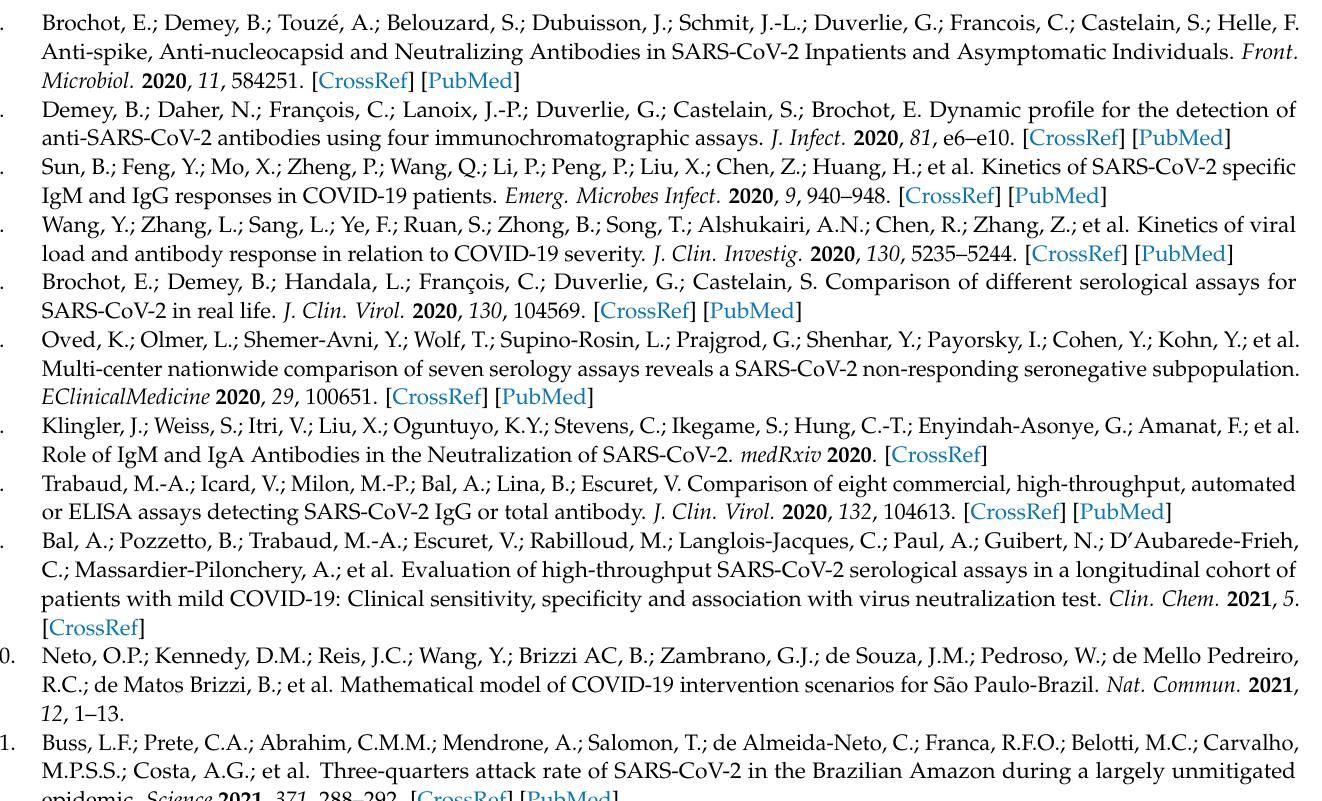
Supplementary Materials: The following are available online at https://www.mdpi.com/article/10 .3390/jcm10091815/s1. Figure S1: Percentage of SARS-CoV-2 positive patients in various serological assays by post-PCR period for women (A), men (B), people over 65 years of age (C), people under 65 years of age (D), people hospitalized for COVID-19 (E), and people not requiring hospitalization (F). Figure S2: Raw data of the results of the 208 samples by assay according to the collection period after the first positive PCR. Table S1: Characteristics of the serological